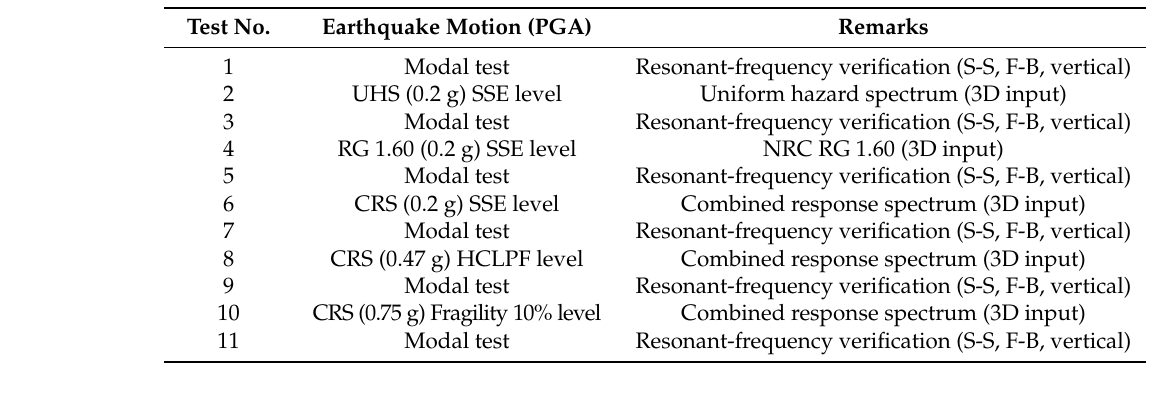
Figure 4. Acceleration comparison for different seismic response spectra: ( a ) side to side and front to back and ( b ) vertical.